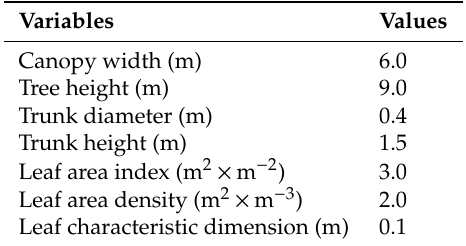
Table 2. Physical characteristics of apricot trees modelled in CTFD model.